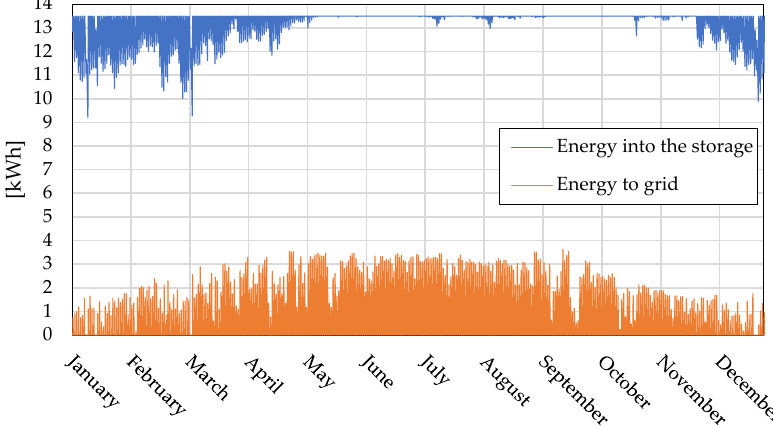
Figure 22. Hourly accumulated electric energy and electricity supplied to the grid. Table 10. The monthly mean charge state of the electric storage